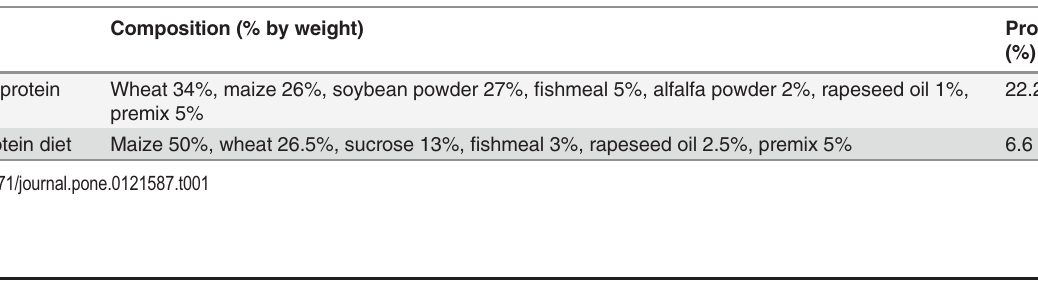
Table 1. Composition of normal and low protein diets fed to dams during pregnancy and the first 10 days of lactation period. Composition (% by weight) Protein Normal protein